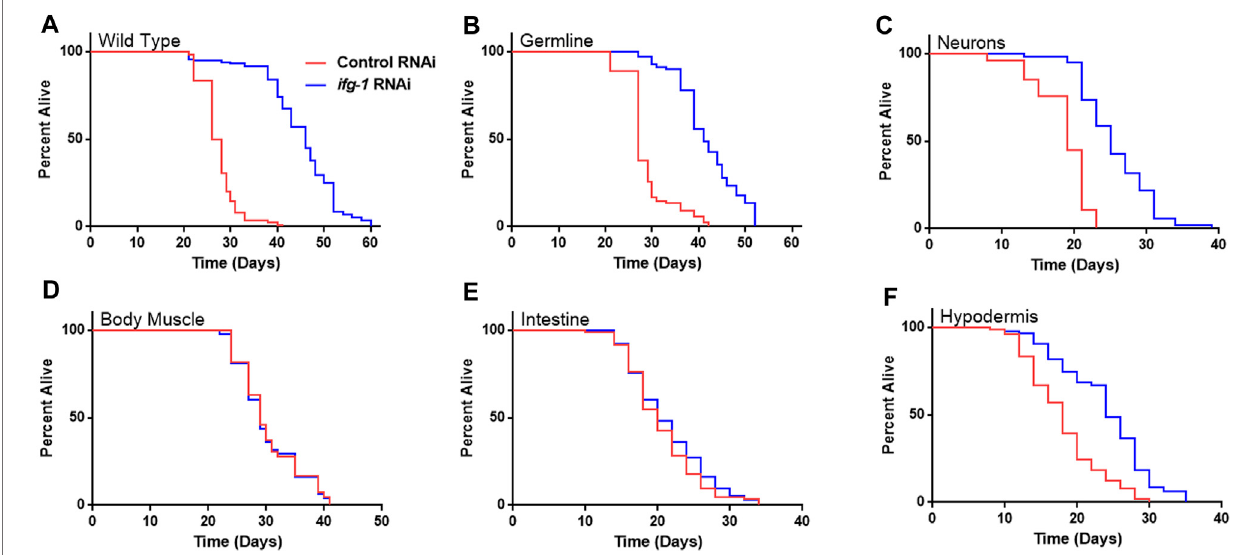
FIGURE 2 | Survival under nutrient deprivation is increased in a tissue-speci fi c manner when ifg-1 is reduced in adulthood. Worms were fed bacteria expressing controlor ifg-1 dsRNAfor2 daysbeginningatadulthood.Nutrientdeprivation wasinitiatedbycompleteremovalfromfood. (A) Median lifespanintheN2wildtype strain increased by 76.9% compared to control ( p < 0.0001). (B) Median lifespan in the MAH23 germline-speci fi c RNAi strain increased by 51.9% compared to control ( p < 0.0001). (C) Median lifespan in the TU3335 neuron-speci fi c RNAi strain increased by 31.6% compared to control ( p < 0.0001). (D) Median lifespan in the WM118 muscle-speci fi c RNAi strain was not signi fi cantly changed ( p (cid:1) 0.91). (E) Median lifespan in the VP303 intestine-speci fi c RNAi strain was not signi fi cantly changed ( p (cid:1) 0.28). (F) Median lifespan in the NR222 hypodermis-speci fi c RNAi strain increased by 33.3% compared to control ( p < 0.0001). Kaplan – Meier survival curves were compared using the Mantel – Cox log-rank test. See Supplementary Table S3 for additional details and replicates.